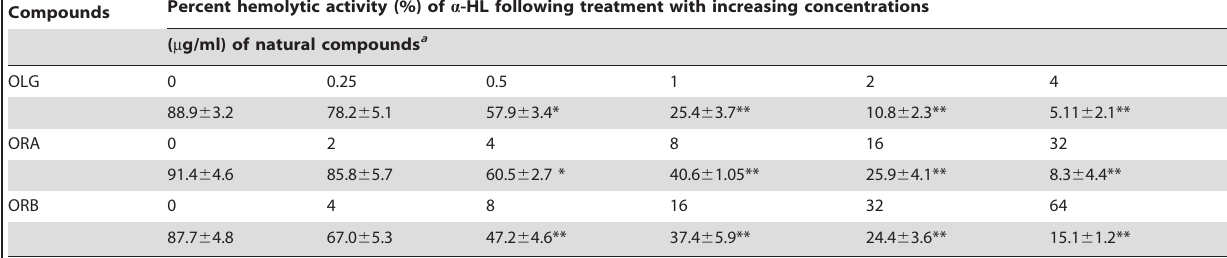
Table 1. The influence of OLG, ORA, and ORB on the hemolysis of a -HL.